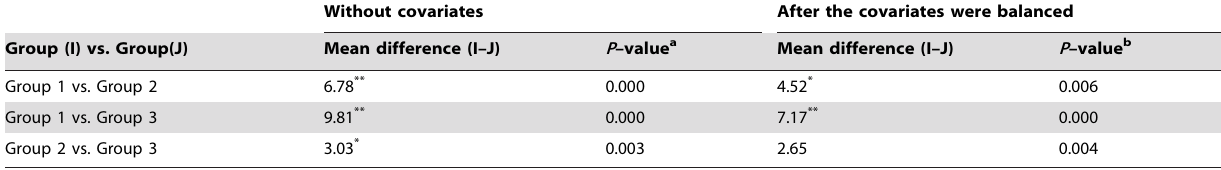
Without covariates After the covariates were